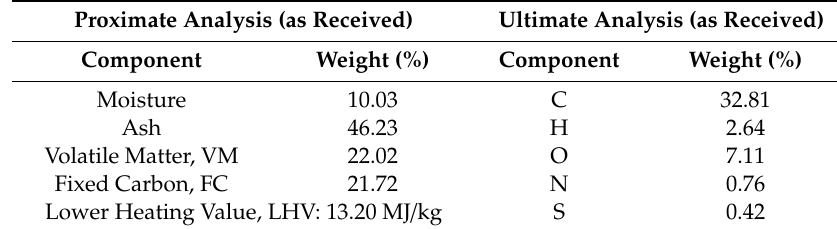
Table 3. The proximate analysis and ultimate analysis of coal (Reprint with permission [6]; 2015, Powder Technol.).